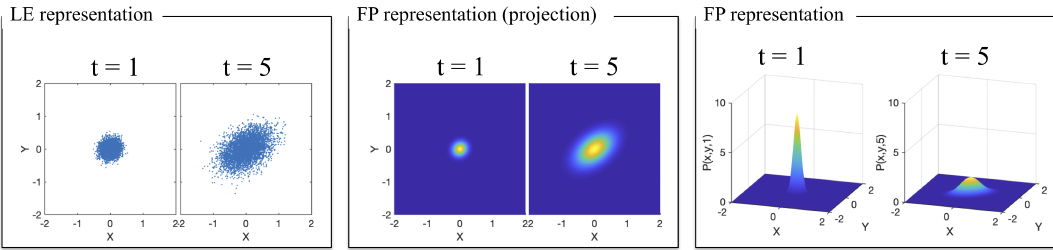
Figure 9. LE and FP solutions for two-dimensional Brownian motion with simple shear flow. For both representations, D = 10 − 2 µ m 2 /s, U = 0.2 µ /s and time is in seconds. For the LE representation, the total number of particles is 5 × 10 3